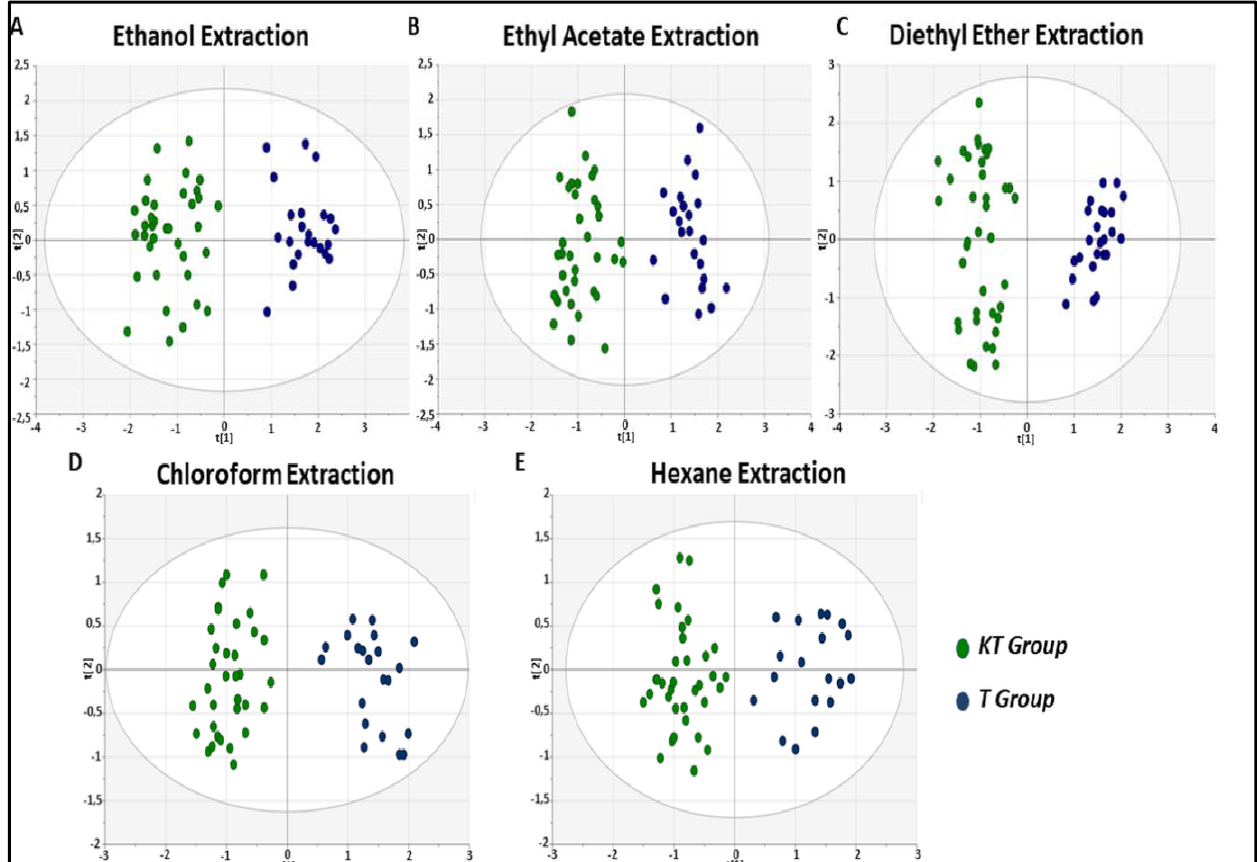
Figure 4. OPLS-DA score plots of the fecal metabolic profiles from the KT and control (T) groups. An overview of the data from each extraction confirms that there are no outlying samples within a 95% confidence interval. Green circles represent KT samples and blue circles represent healthy control samples. ( A ) OPLS-DA score plot model showing discrimination of stable KT patients from controls based on the Ethanol extraction method, with R2(X) = 0.602, R2(Y) = 0. 881, Q2 = 0.71, and CV-ANOVA p = 2.85 × 10 − 9 values. ( B ) OPLS-DA score plot model showing discrimination of stable KT patients from controls based on the Ethyl Acetate extraction method, with R2(X) = 0.291, R2(Y) = 0.871, Q2 = 0.718, and CV-ANOVA p = 1.56 × 10 − 14 values. ( C ) OPLS-DA score plot model showing discrimination of stable KT patients from controls based on the Diethyl ether extraction method, with R2(X) = 0.486, R2(Y) = 0.938, Q2 = 0.815, and CV-ANOVA p = 2.02 × 10 − 24 values. ( D ) OPLS-DA score plot model showing discrimination of stable KT patients from controls based on the Chloroform extraction method, with R2(X) = 0.505, R2(Y) = 0.889, Q2 = 0.791, and CV-ANOVA p = 1.07 × 10 − 12 values. ( E ) OPLS-DA score plot model showing discrimination of stable KT patients from controls based on the Hexane extraction method, with R2(X) = 0.341, R2(Y) = 0.873, Q2 = 0.798, and CV-ANOVA p = 9.63 × 10 − 19 values.